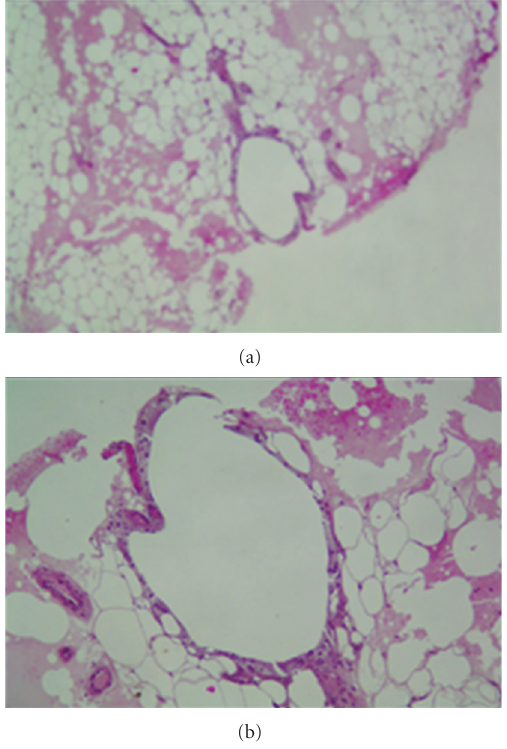
Figure 3: (a) ( × 100) and (b) ( × 400) coloration HE: lobular inflammatory infiltrate and adipocyte necrosis.